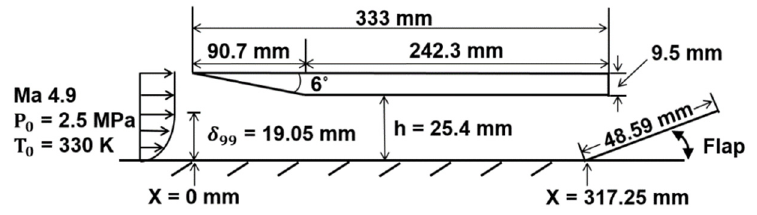
Figure 1. Schematic of the scramjet inlet-isolator model.